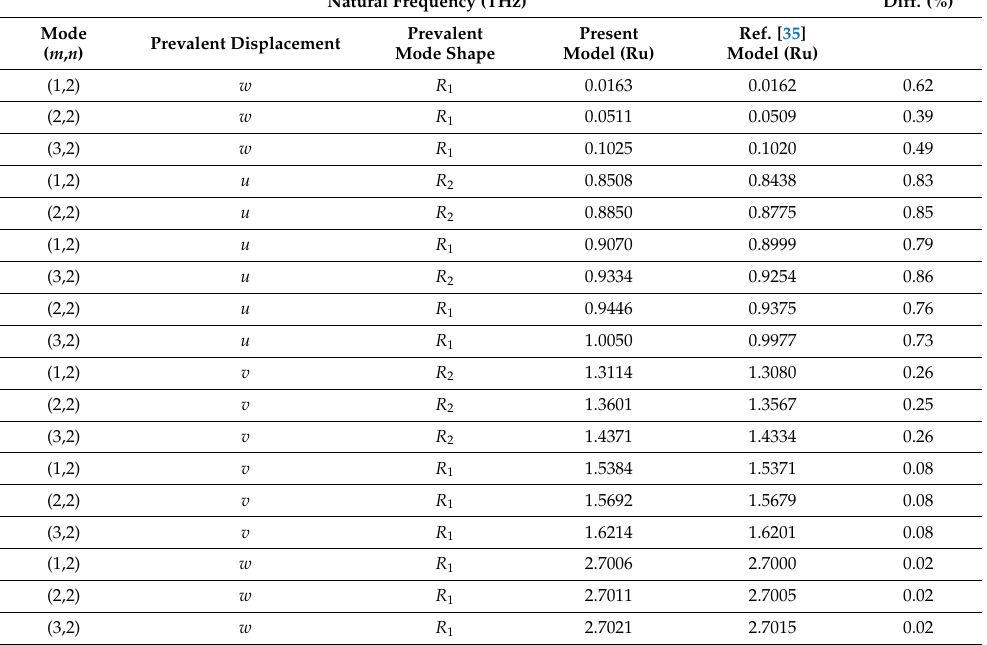
Table 3. Natural frequencies (THz) of a simply supported DWCNT with innermost radius R 1 = 5 nm and aspect ratio L / R 2 = 10. Donnell shell theory. Isotropic elastic shell model. Van der Waals interaction coefficient expressed on the basis of Ru’s formulation. Circumferential flexure modes ( n = 2). Comparisons between present and Ref. [35] models.